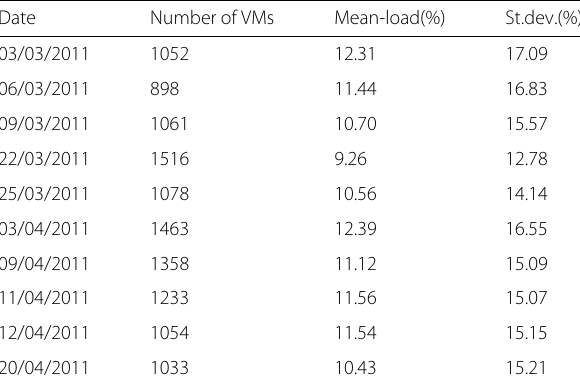
Table 2 Statistical characteristics of PlanetLab workloads traces [18]